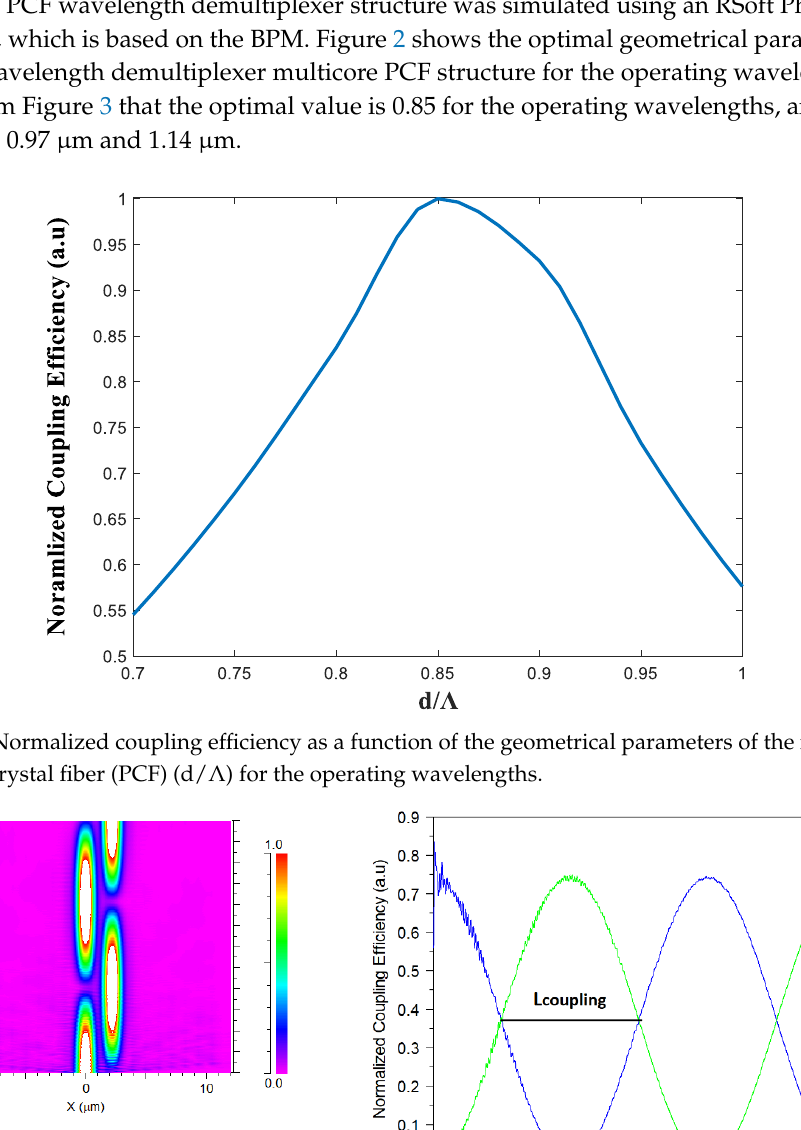
Figure 3. Energy transfer between core 1 and core 8 for the 1565-nm wavelength. ( a ). Intensity profile. ( b ). Normalized coupling efficiency as a function of the propagation direction.